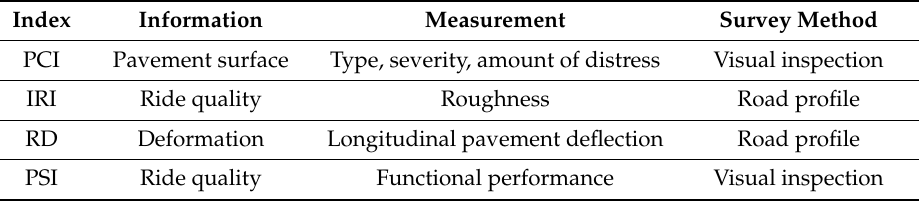
Table 1. Indices review for road pavement surface